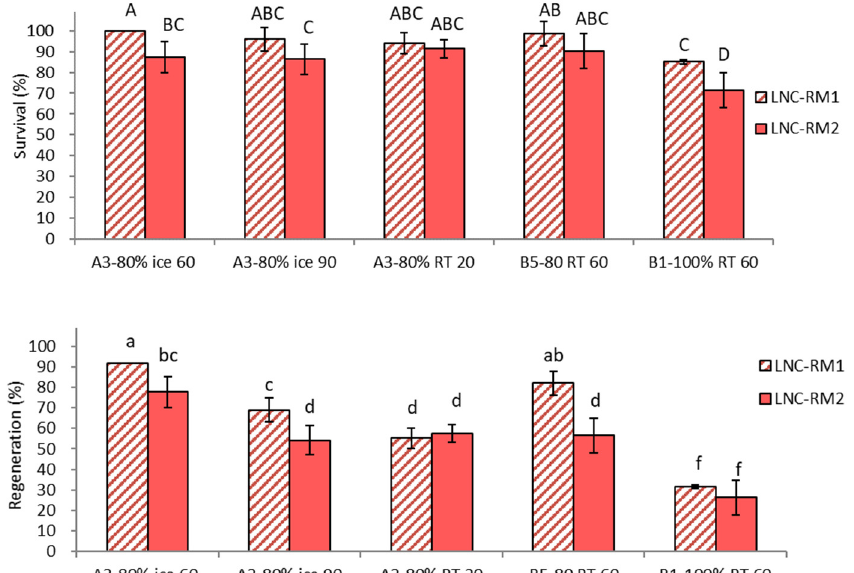
Figure 1. Effect of vitrification solution treatment conditions and initial (first 5 days) regrowth on ammonium-free (RM1) or ammonium–containing (RM2) medium on survival and regeneration of Pogostemon yatabeanus shoot tips in the droplet-vitrification procedure. Shoot tips were cryoprotected but not cryopreserved (LNC). Treatment conditions are listed in the table in Section 4.2.